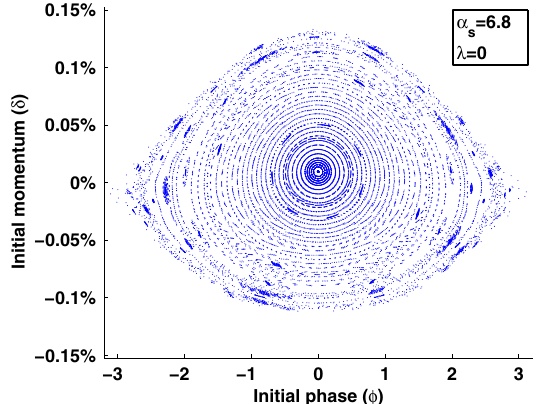
FIG. 8. Poincaré map for conventional slip stacking with a value of α s corresponding to 65 kV main rf voltage and 1680 Hz rf frequency separation.